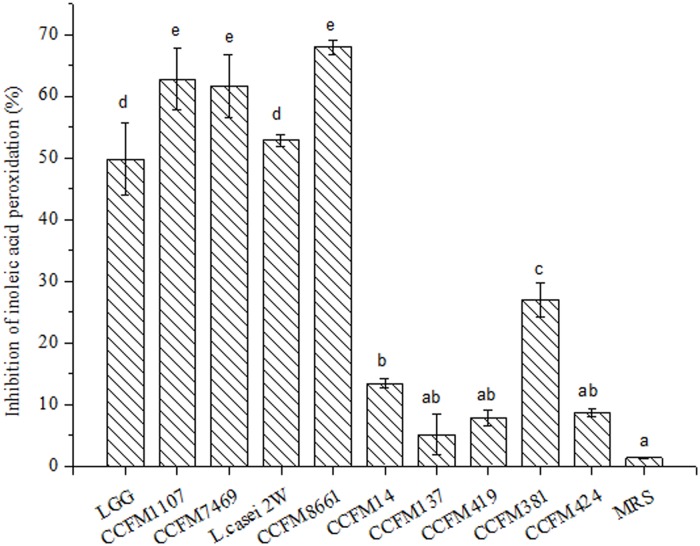
ILAP of the CFSs (mean ± SD, n = 3).MRS control sample without lactobacilli. Different letters mean statistically significant differences at p < 0.05. Bars with no common letters are significantly different (p < 0.05).